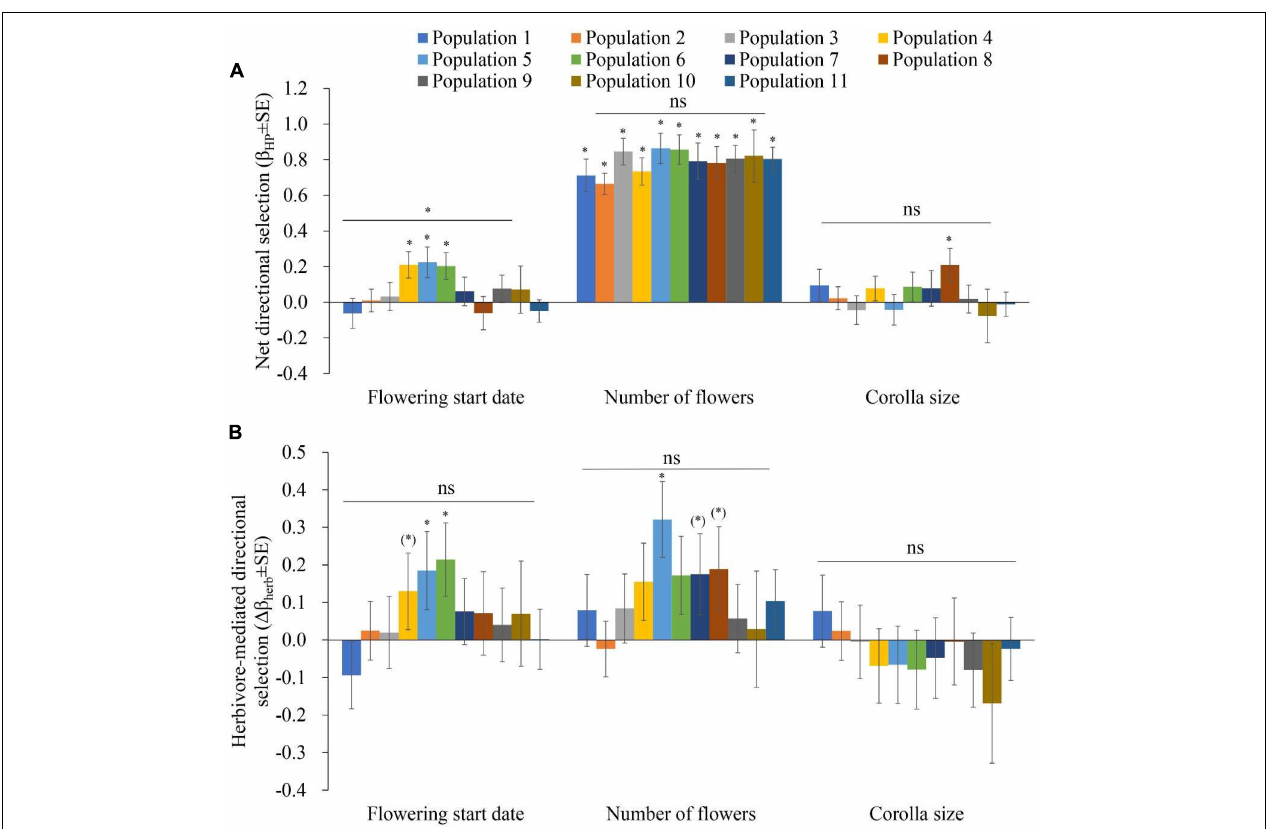
FIGURE 3 | Phenotypic selection in 11 populations of Primula florindae : (A) Net directional selection gradients ( β HP ± SE) and (B) herbivore-mediated directional selection gradients ( (cid:49) β herb ± SE) related to the flowering start date, number of flowers and corolla size among populations. Symbols above individual bars indicate the level of significance of the selection gradients. Symbols above the lines indicate whether directional selection varied among the populations, as indicated by the significant trait × population and trait × treatment × population terms in the ANCOVAs. ∗ P < 0.05; ( ∗ ) P < 0.1; and ns P >